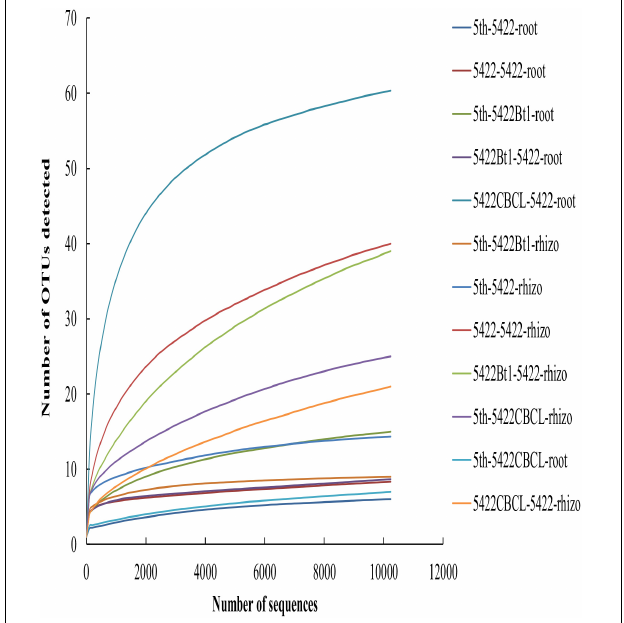
FIGURE 1 | Taxa accumulation curves of AMF colonizing in roots and rhizosphere soils in all samples. The legend was labeled as follows: the fifth season or straw returning of maize variety -maize variety-sample type. The fifth season or straw returning of maize varieties including 5422Bt1, 5422CBCL and 5422; sample types including roots and rhizosphere soils. Rhizo, rhizosphere